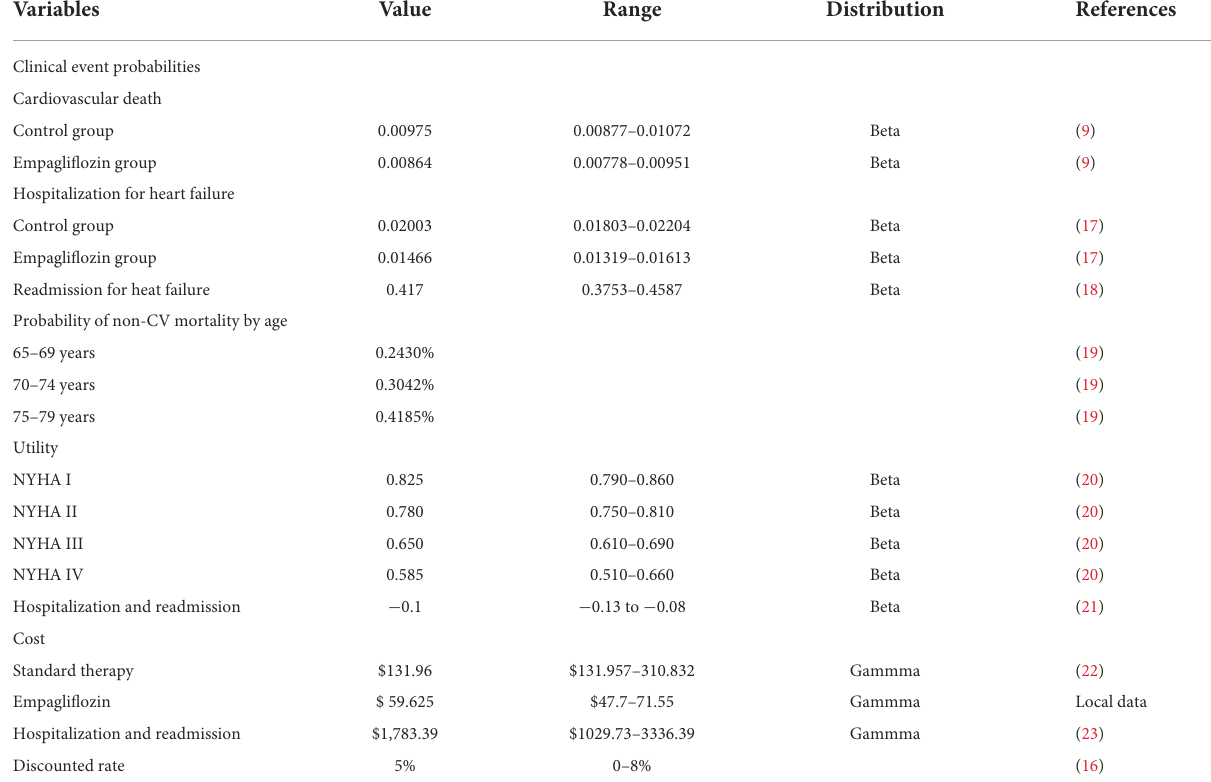
TABLE 1 Selected model inputs.